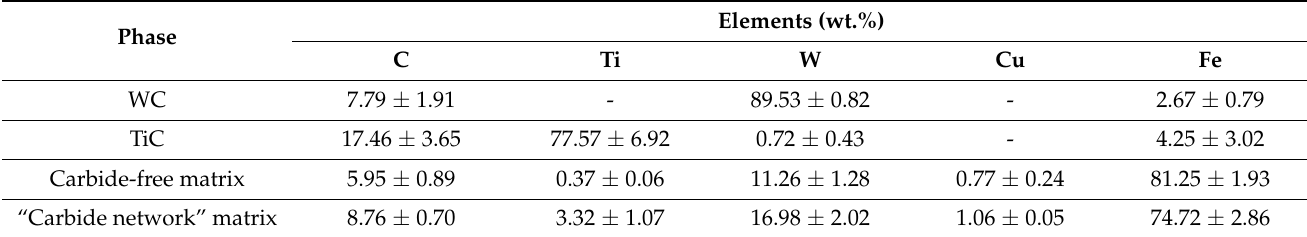
Table 1. Phase chemical composition of the